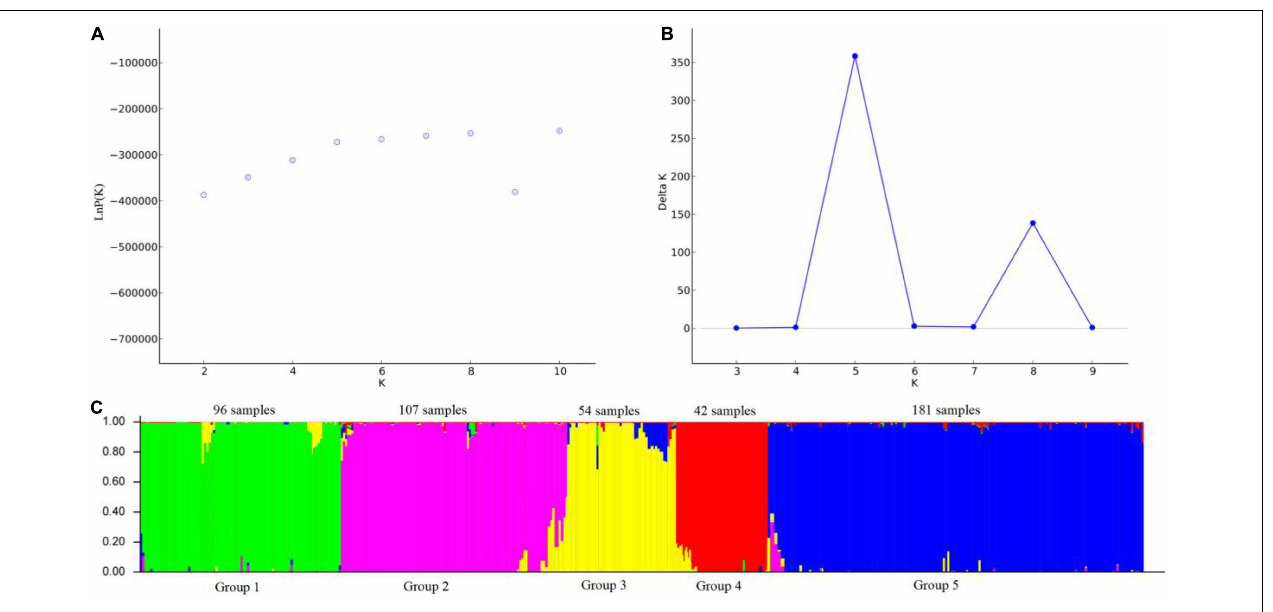
FIGURE 5 | Analysis of the population structure of 480 Psathyrostachys juncea Individuals. (A) The average log-likelihood of K -value against the number of K ; (B) Relations between the number of K and (cid:49) K , based on the model developed by Evanno et al. (2005). (C) The population structure of P. juncea determined using STRUCTURE 2.3.4 software (Kölliker et al., 2001) ( K = 5). Green area: Group 1; Purple area: Group 2; Yellow area: Group 3; Red area: Group 4; Blue area: Group